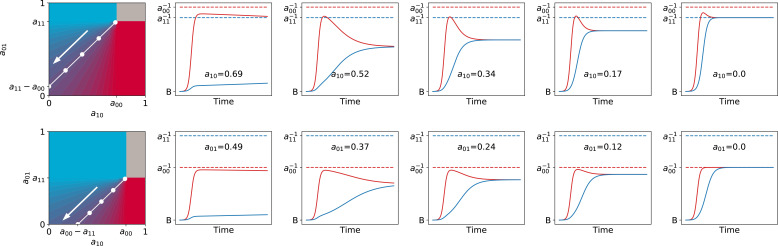
Asymmetric interaction ensures fastest convergence toward the ecological equilibrium.Particle population dynamics are illustrated for increasingly asymmetric values of (a01,a10), keeping the ecological equilibrium fix at x*=0.5 (along white manifold, in the direction of the arrow). The top panels correspond to cases when the faster-growing particles have a higher carrying capacity ((a00,a11)=(0.7,0.8)), the bottom panels to the opposite ((a00,a11)=(0.8,0.5)). In both cases r0=60, r1=40, T=1, B=0.001.